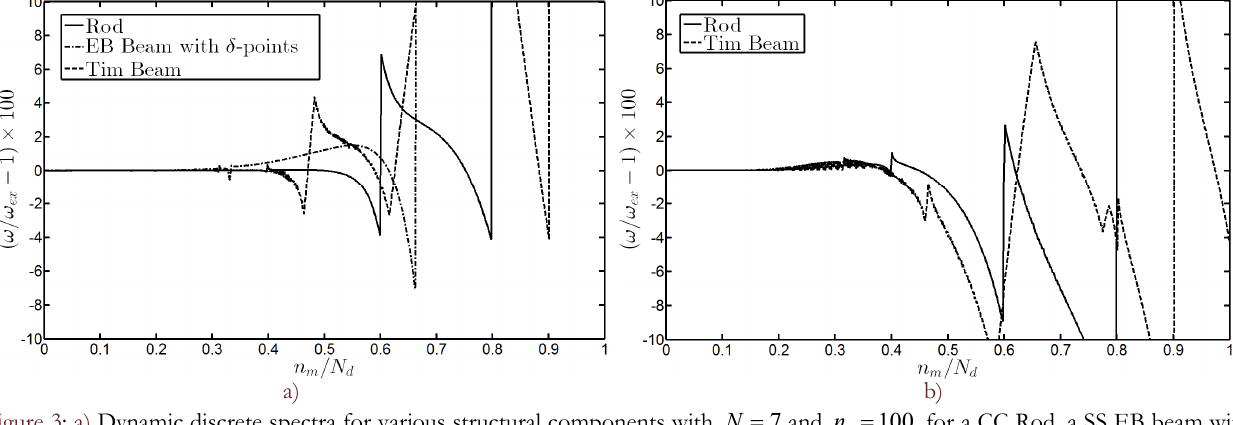
Figure 3: a) Dynamic discrete spectra for various structural components with 7 N  and 100  -points (1/2) and a CC Tim beam using PDQ basis functions and Leg-Gau grid distribution. b) Dynamic discrete spectra for several structural components using Weak Formulation (WFEM) with 7 N  and 100 basis functions and Leg-Gau-Lob grid